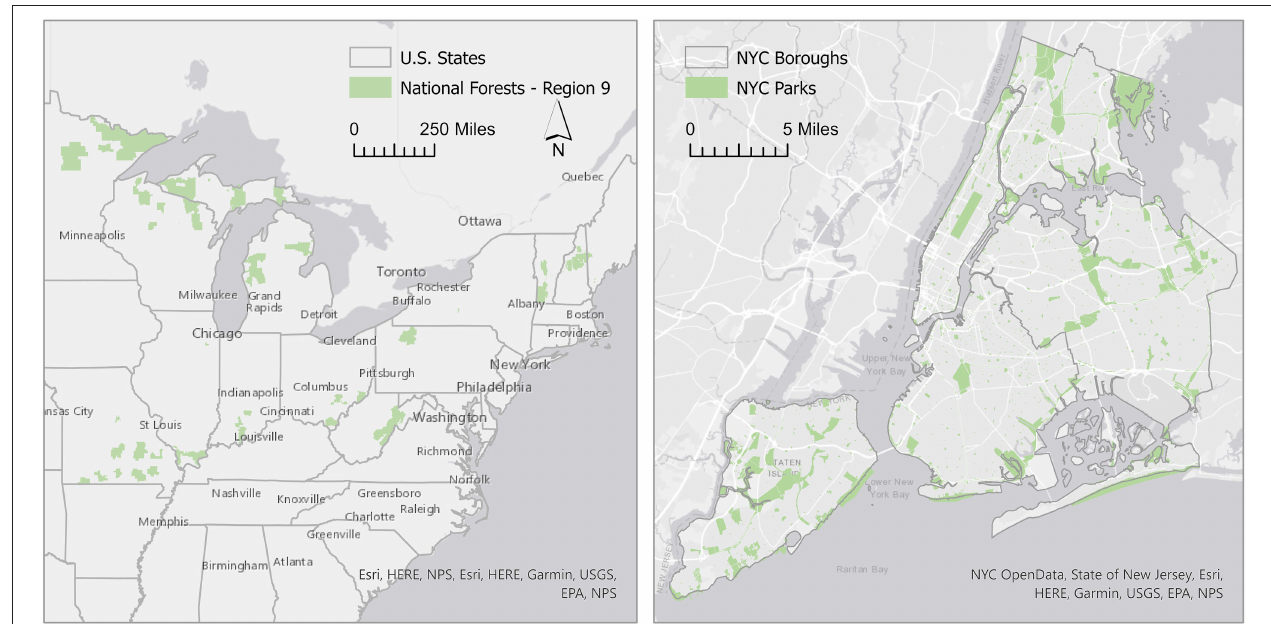
FIGURE 1 | Map of the study area. Left: Forest Service Eastern Region National Forests and Grasslands. Right: New York City parkland. Map created by Michelle